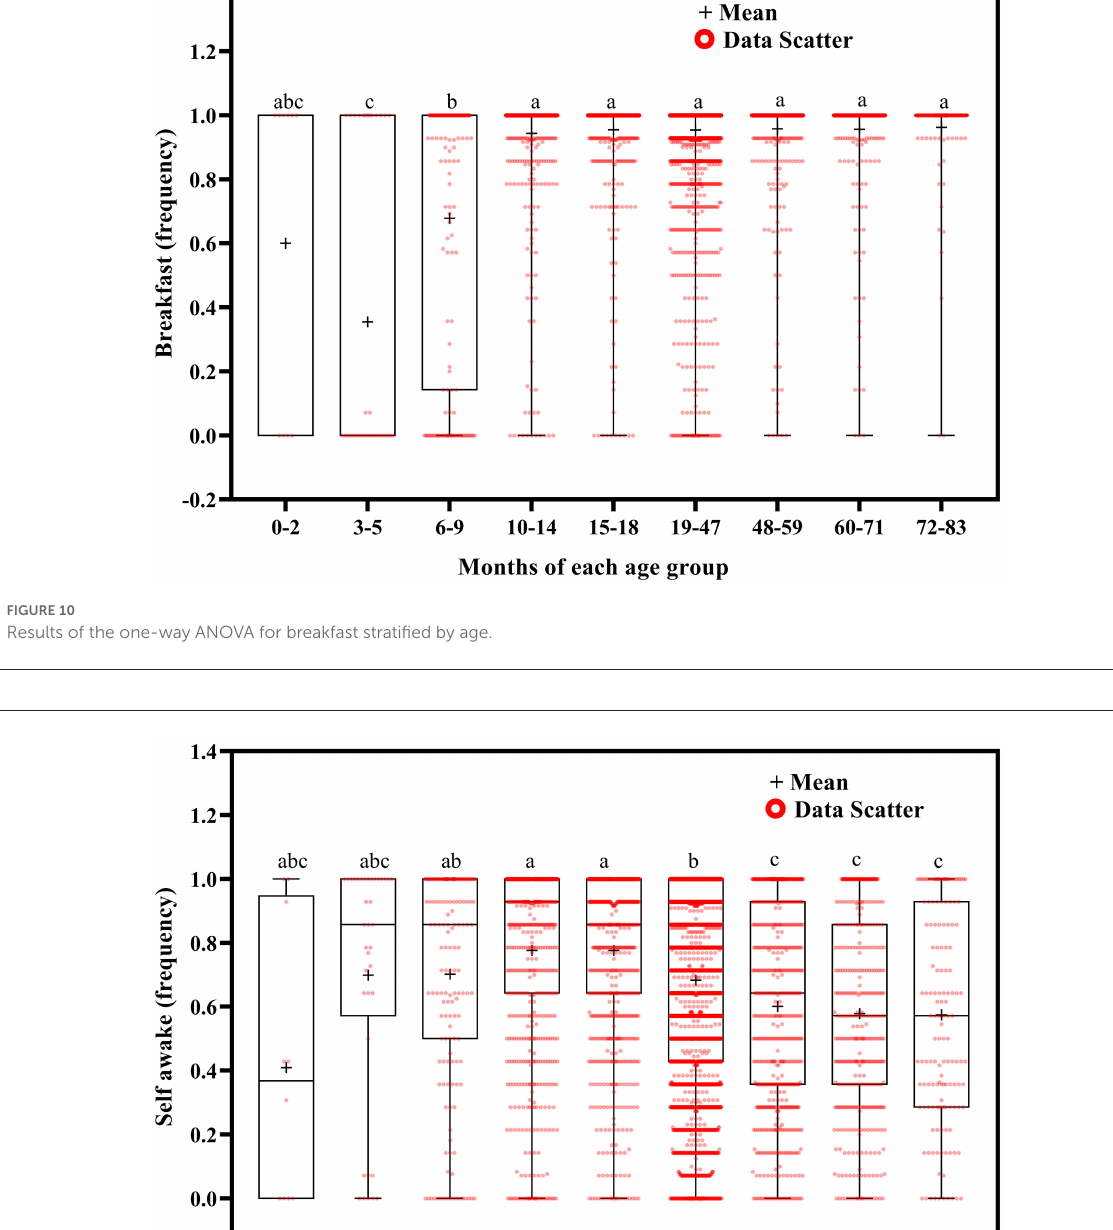
than at ages 15–83 months ( p < 0.001); at ages 15–18 months than at ages 19–83 months ( p < 0.001); at ages 19–47 months than at 48–83 months ( p < 0.001); and at ages 48–59 months than at ages 72–83 months ( p =